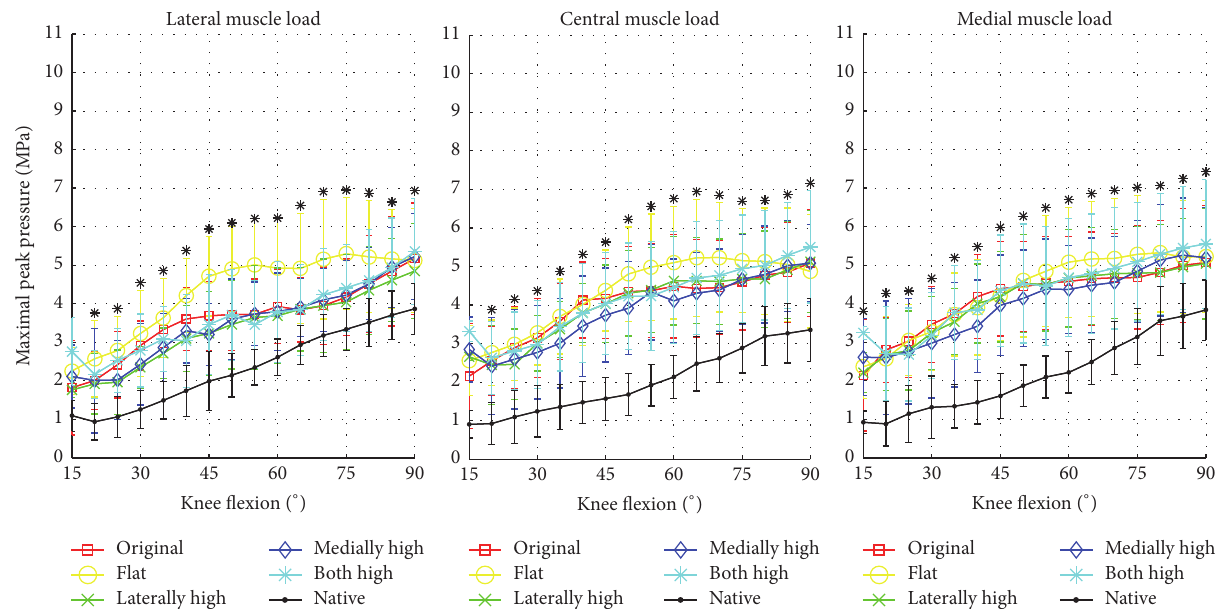
Figure 8: Change in maximum pressure with increased lateral, central, and increased medial muscle load after implementation of different design variations with patellar resurfacing (native, original, flat, laterally high, medially high, and both sides high) ( ∗ significant